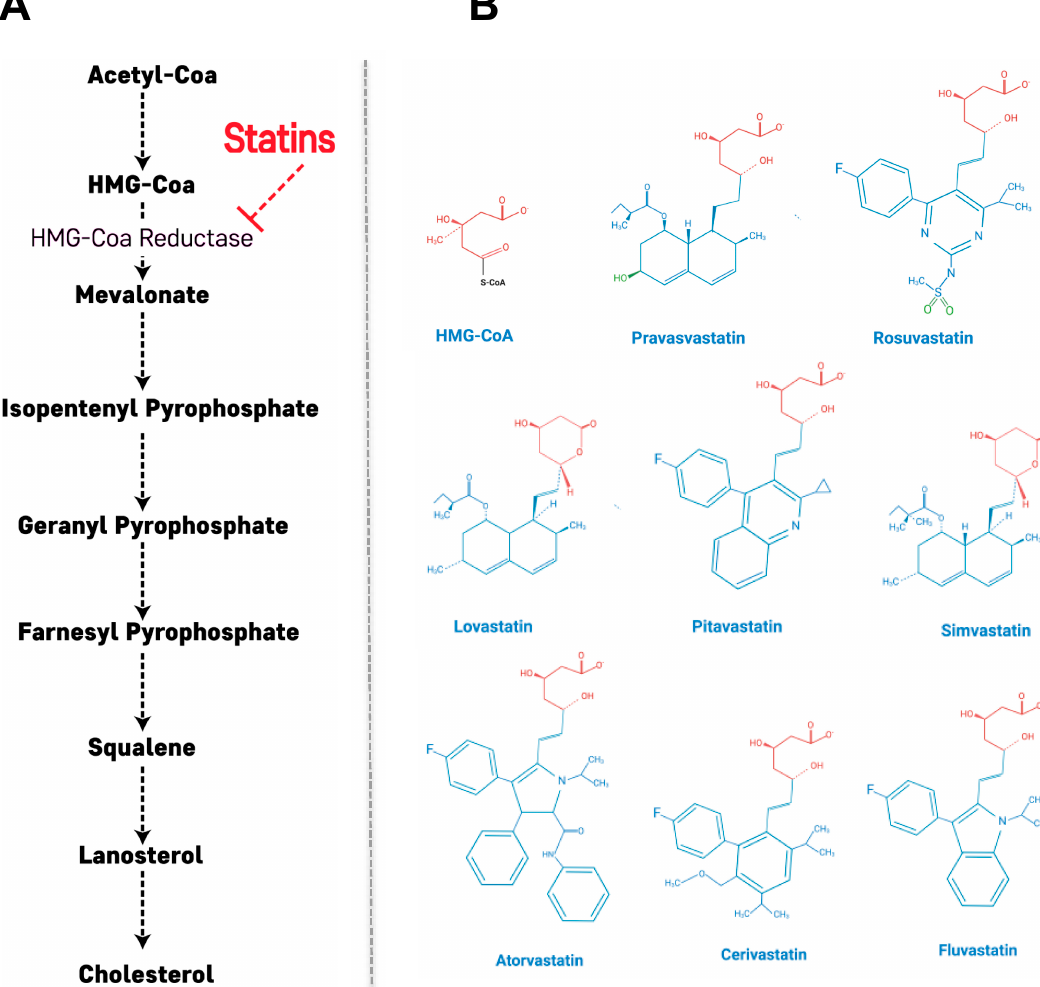
Figure 1. Statin-induced inhibition of the mevalonate pathway and structure of statins. ( A ) Inhibition of HMG-CoA reductase significantly blocks the production of mevalonate, a necessary precursor for cholesterol synthesis. Mevalonate is the building block for a variety of other compounds. ( B ) Structural formulas of statins and HMG-CoA. The HMG-like moiety (in red) is conserved in all statins. The polar substituents responsible of pravastatin and rosuvastatin are colored in green.